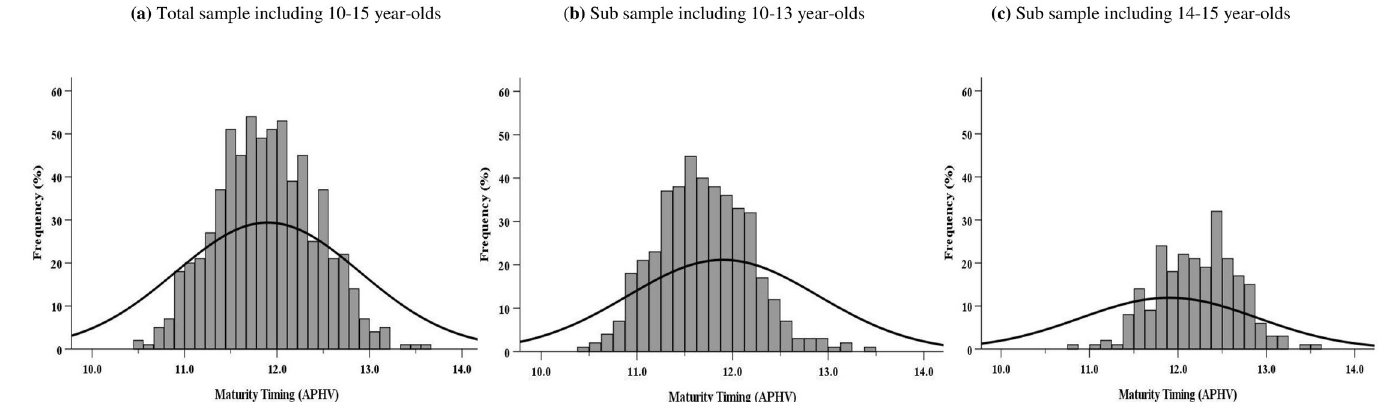
Fig 1. Frequency distributions of maturity timing (APHV) for N = 663 female 100-m FC swimmers plotted relative to expected female normative population APHV distributions. Fig 1a illustrates ‘All’ sample distribution; 1b illustrates the distribution of 10–13 year-olds; and 1c illustrates the distribution of 14–15 year-olds.